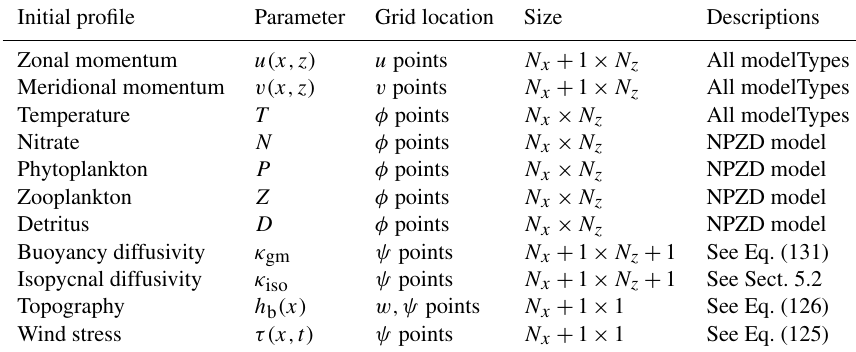
Table 5. A table outlining the initial profiles that MAMEBUS expects during initialization. To visualize the grid locations, see Fig. 2. Each initial profile is included in “all modelTypes” unless otherwise stated. Note that N x is the number of zonal domain points and N z is the number of vertical domain points given in Table